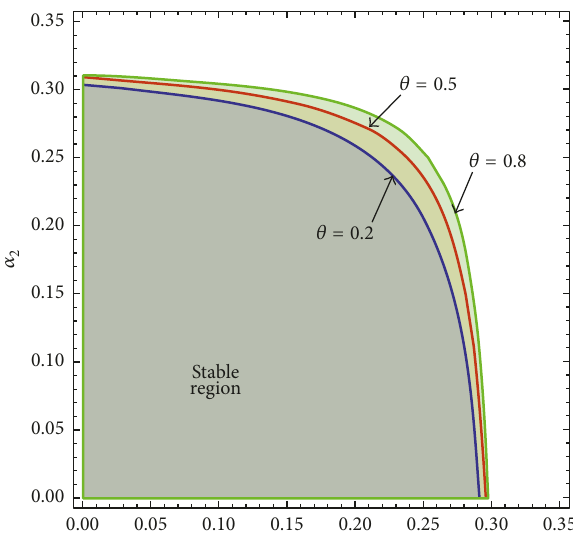
Figure 13: The stable region of adjustment speeds when 𝛼 = 0.5 and 𝑤 = 0.5 . 𝑖